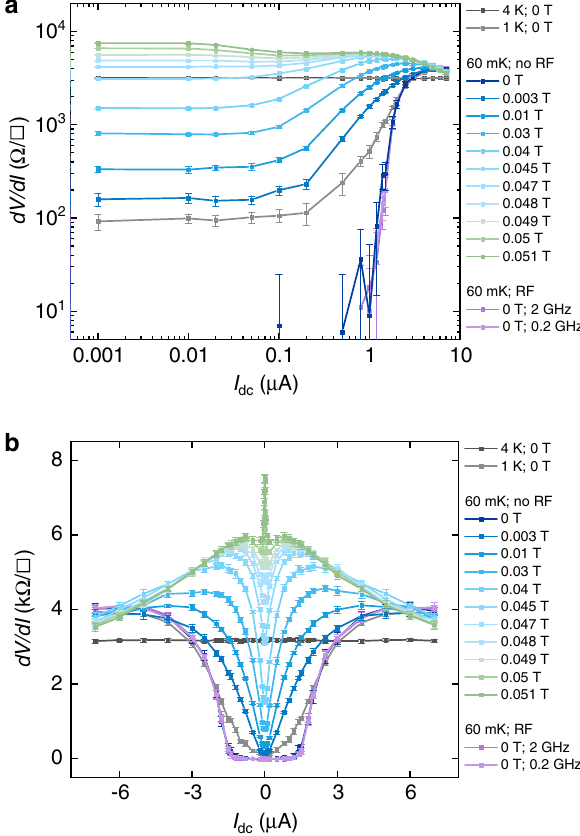
Fig. 5 Differential resistivity in perpendicular magnetic fi eld or subject to RF injection. a Differential resistivity dV/dI versus direct current bias for S2G at 60 mK, showing a superconducting critical current of about 1 μ A. Injection of RF signal of 2 GHz (dark purple) and 0.2 GHz (light purple) leads to a slight increase in critical current. Linear response below at least 20 nA is demonstrated in the anomalous metallic phase. Dark gray curve is dV / dI at 4 K, marking the normal state value. b Same data shown in full linear scale. Zero- bias features evolve from a dip at low fi eld to a sharp peak at higher fi eld, corresponding to the anomalous metallic phase and insulating phase, respectively. Error bars indicate standard